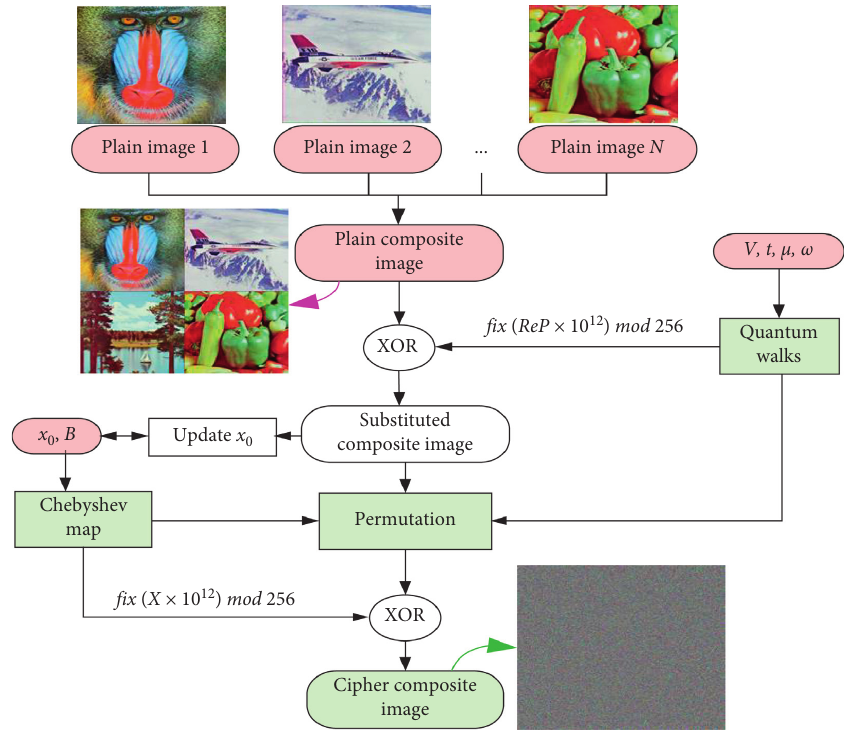
Figure 1: Outline of encryption procedure for the proposed multiple-image